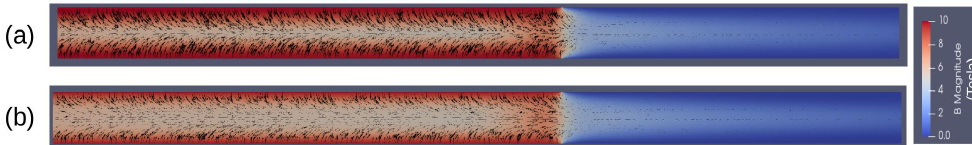
Figure 6. Distribution of magnetic induction in the ( a ) x-y plane and ( b ) x-z plane. Magnets are in the repulsive